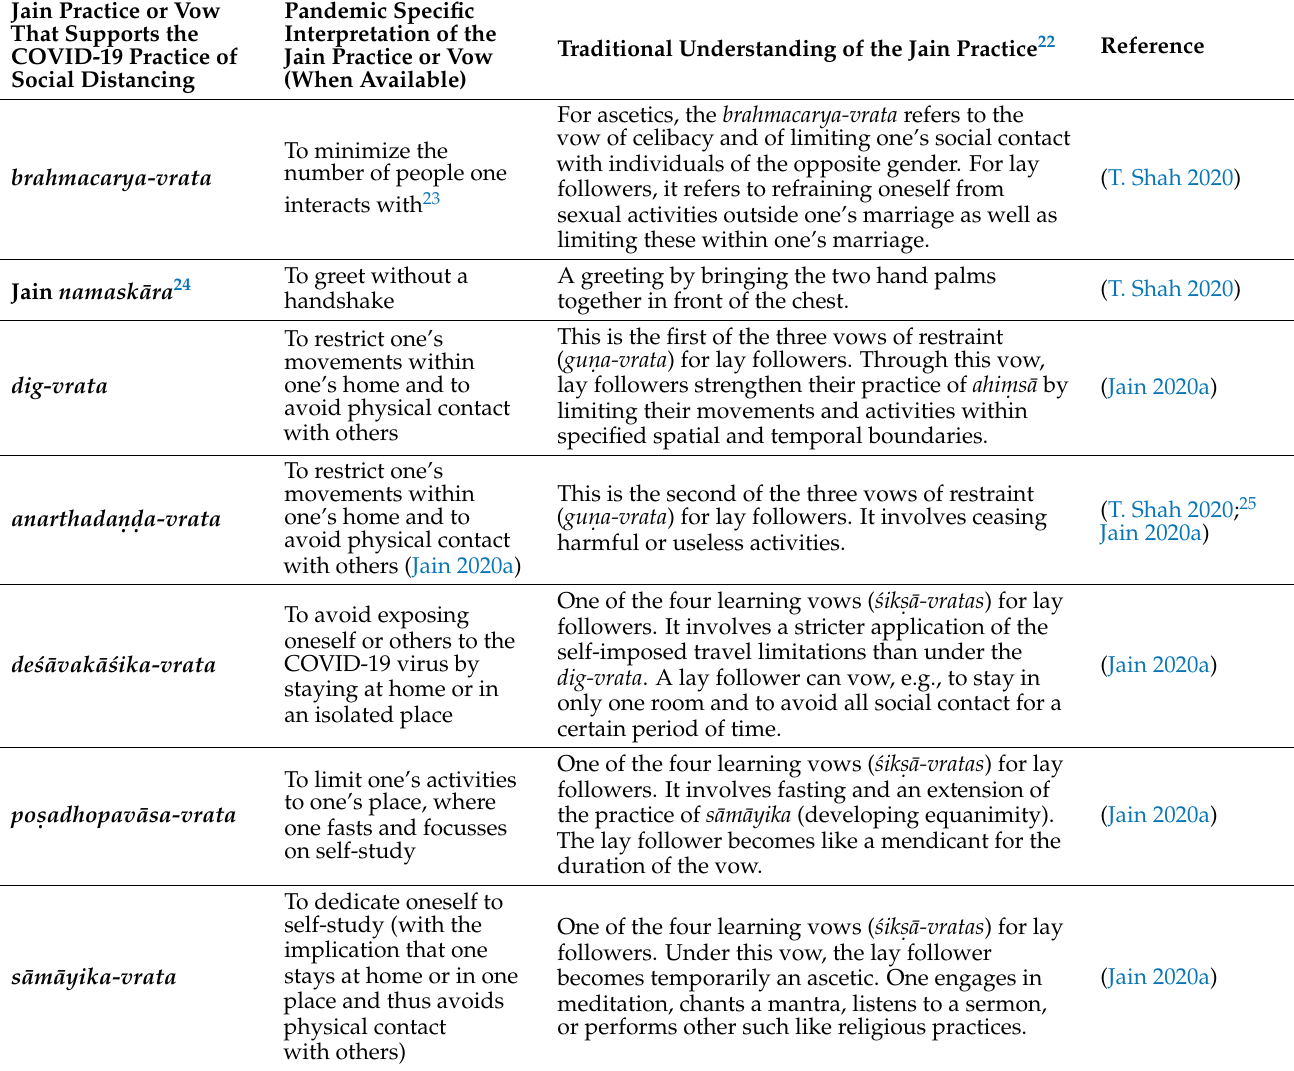
Table 2. Jain Practices and Vows that Support the COVID-19 Practice of Social